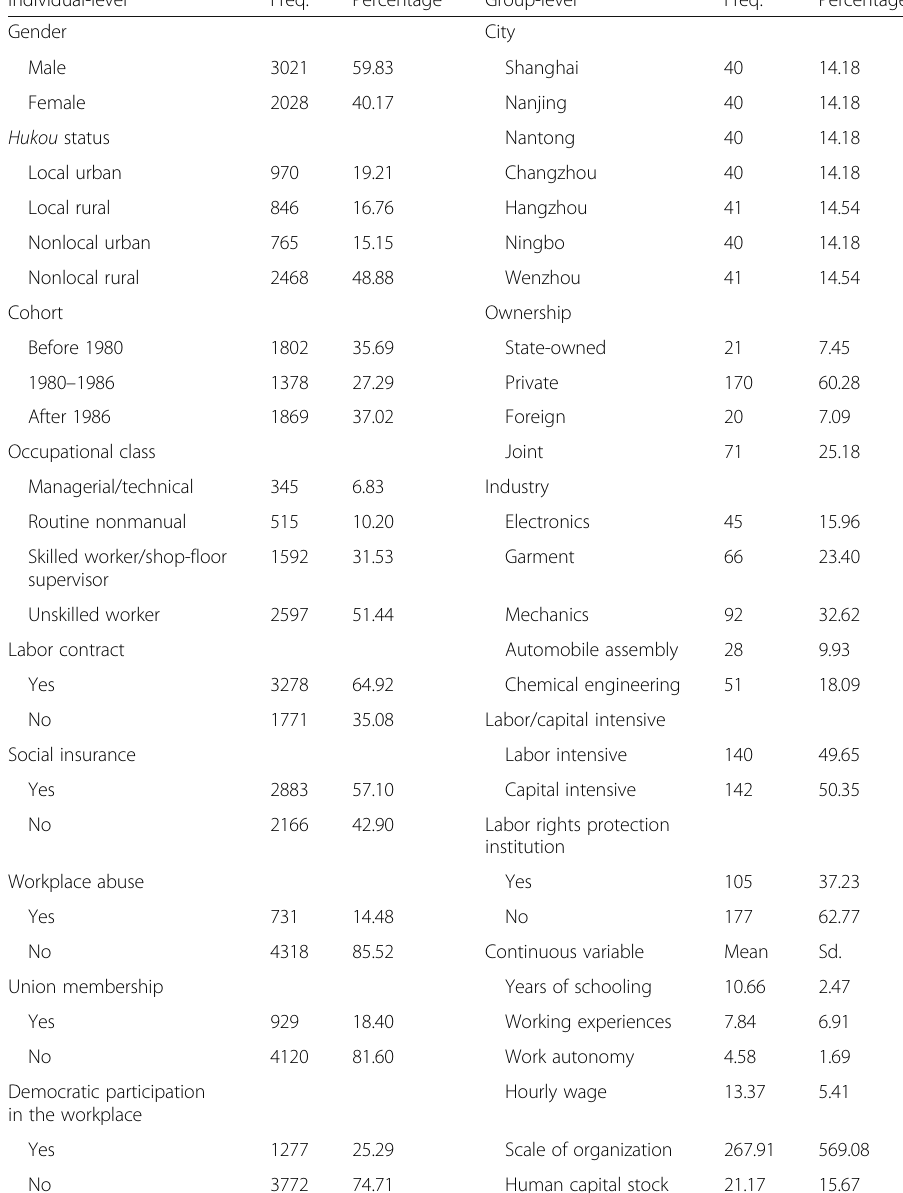
Table 2 Descriptive statistics of controls